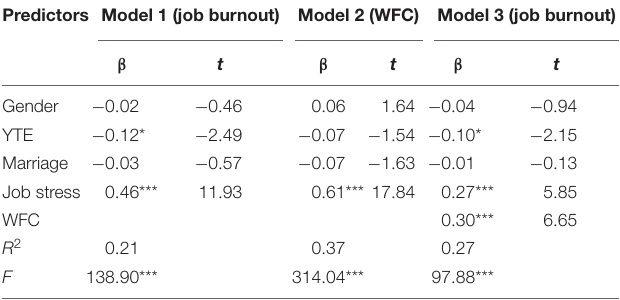
TABLE 2 | Testing the mediation effect of job stress on burnout.